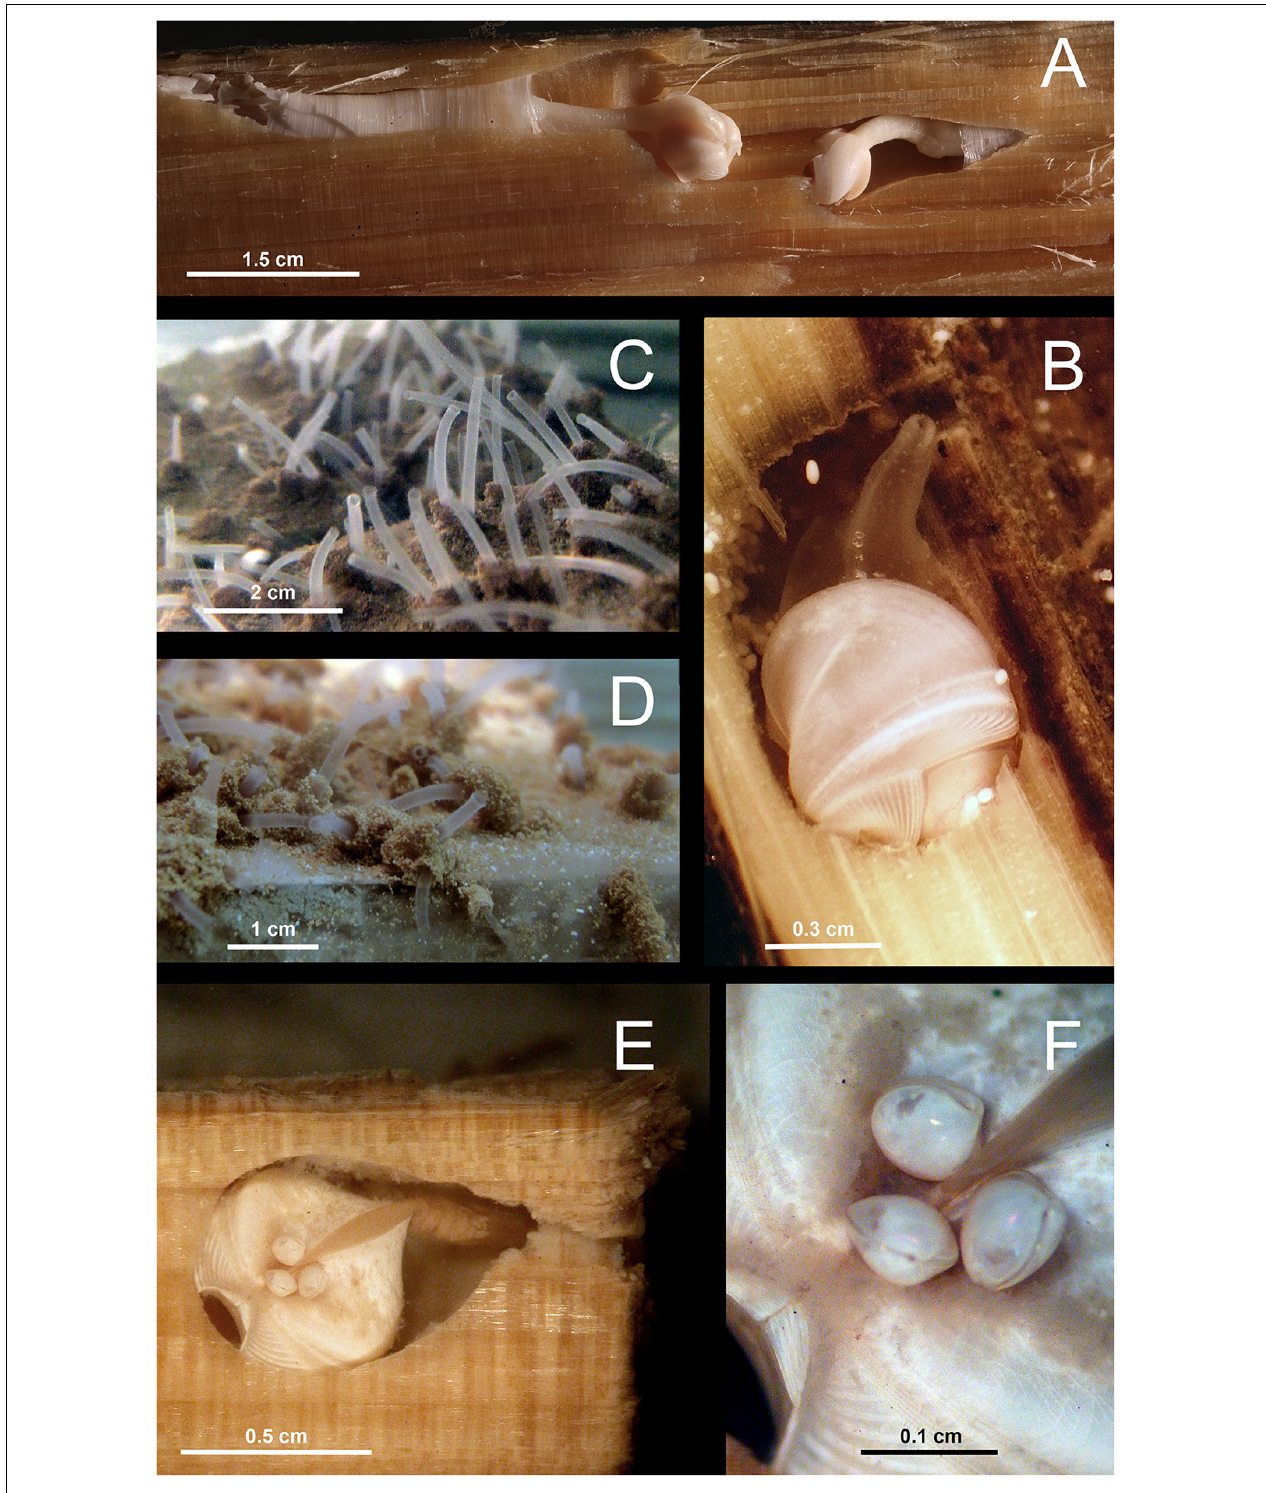
FIGURE 4 | Examples of Xylophagaidae in experimentally deposited wood. (A) Xyloredo sp. 1 in pine wood from Avilés Canyon, 2,000 m depth. (B) Xylophaga dorsalis in wood from La Fonera Canyon, 130 m deep. (C,D) Living Xylophagaidae from La Fonera Canyon, 1100 m deep, kept in aquarium for several days after recovery. (C) Siphons emerging from wood and (D) fecal chimneys around the siphons. (E) Xylonora sp. 2 in a Chemecoli fir wood cube from the Rainbow hydrothermal vent field with small individuals attached on the dorsal shell posterior to umbo. (F) Close-up of the small individuals attached to Xylonora sp. 2.